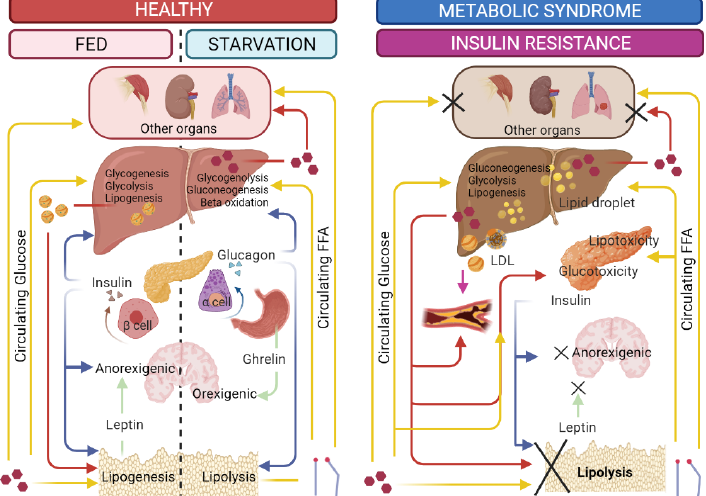
Figure 2. A comparison of metabolic processes in healthy people and those with metabolic syndrome. Insulin controls a variety of metabolic processes in the body. Its primary function is to keep systemic glucose levels under control. During the fed state, glucose is absorbed by the intestine, increasing circulating nutrients, such as glucose, amino acids, and lipids. The beta cells of the pancreas produce insulin, which aids in the uptake of glucose in various tissues and organs. Insulin promotes glycogenesis, glycolysis, and lipogenesis in the liver. This also boosts the production of high-density lipoprotein (HDL) in the liver, which facilitates lipid trafficking. Insulin stimulates lipogenesis in adipose tissue, which causes it to secrete leptin. Leptin and insulin stimulate anorexigenic signaling in the brain, which helps to regulate appetite. On the other hand, fasting and starvation reduce insulin levels, resulting in increased lipolytic activity in adipose tissues. The secretion of glucagon by alpha cells promotes lipolysis in adipose tissue, increasing the amount of free fatty acids in circulation for the liver and other organs. Insulin resistance, on the other hand, inhibits glucose uptake by tissues and organs, causing blood glucose levels to rise. It cannot antagonize lipolysis in the adipose tissue, resulting in more free fatty acids entering the bloodstream. High levels of glucose and fatty acids induce oxidative stress and toxicity to tissues and organs. Fatty acids and glucose enter the liver, promoting lipid droplet generation, which eventually leads to stenosis. Further, LDL production in the liver is upregulated, increasing the risk of cardiovascular diseases. Insulin resistance also activates the orexigenic center of the brain, which causes a person to have an increased appetite. (Created with